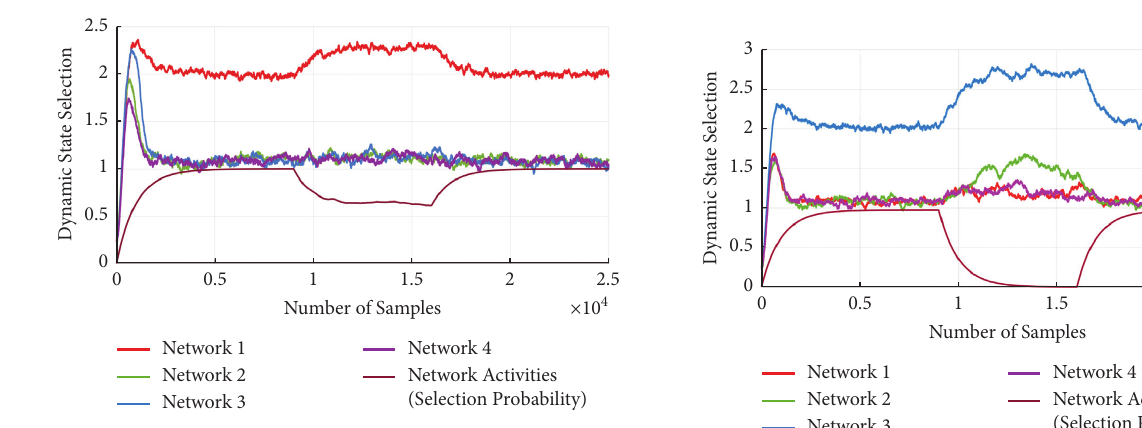
Figure 2: Effect of threshold on network connectivity for � 1 ) . sensitivity � 5 ( V thrl